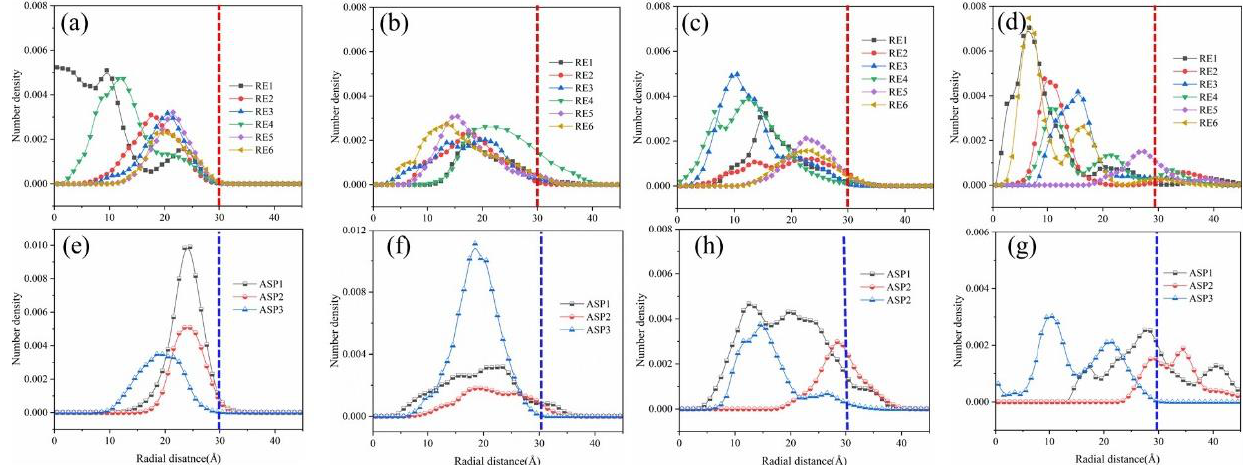
Figure 7. Radial number density of asphaltene and resin in the last 2.0 ns of NVT simulation for System E-I to System E-IV. The radial number density of six resin molecules ( a – d ). The radial num- ber density of asphaltene molecules ( e – g